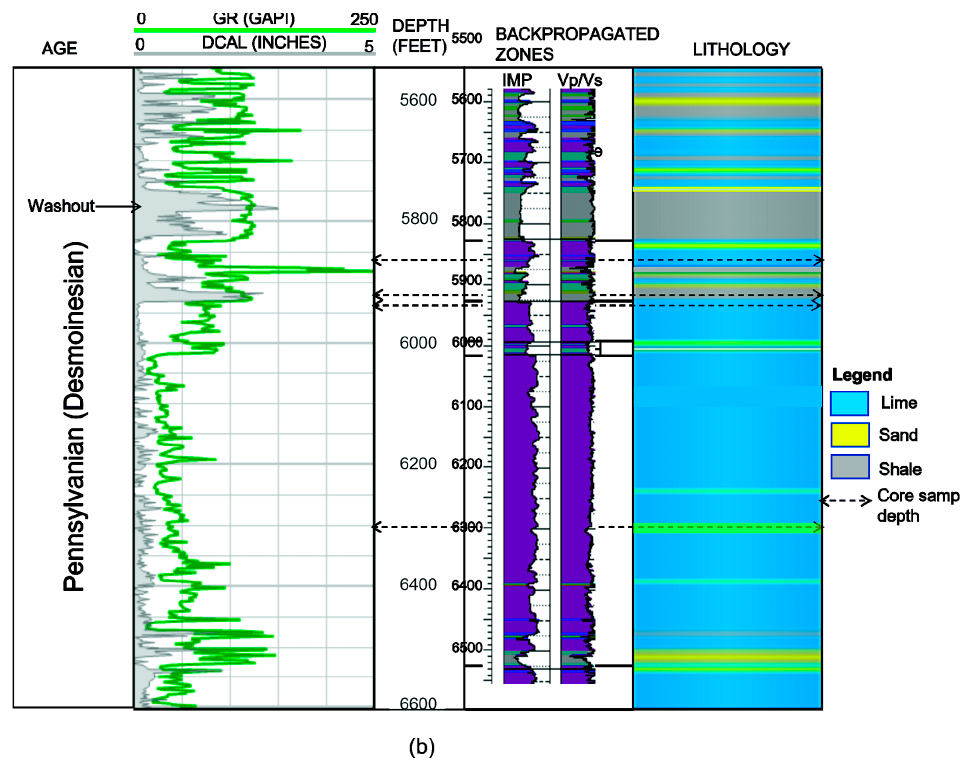
Figure 5. Results of back propagation of different zones along two trends in Figure 4 onto P-impedance and Vp/Vs-ratio logs to identify corresponding depth intervals of zones in logs, showing that ( a ) different zones along lower trend (low-Vp/Vs-ratio deposits) are found in wells 1, 2, 3, 5, 6, and 7, whereas zones along upper trend (high-Vp/Vs-ratio deposits) are found in wells 4 and 8. ( b ) Comparison of P-impedance and Vp/Vs logs (resultants of back propagation of different zones with lithology log) showing corresponding lithology of different zones in well 6. Note: IMP—P-impedance, k in impedance value means 1000.